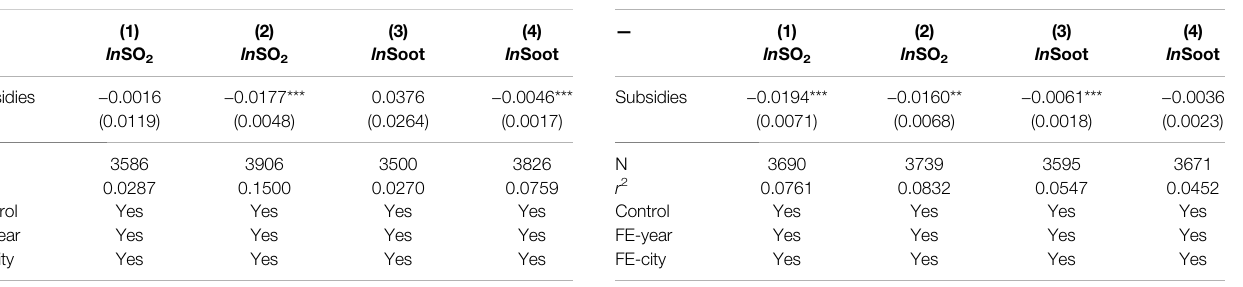
TABLE 7 | Heterogeneity of fi rm size.